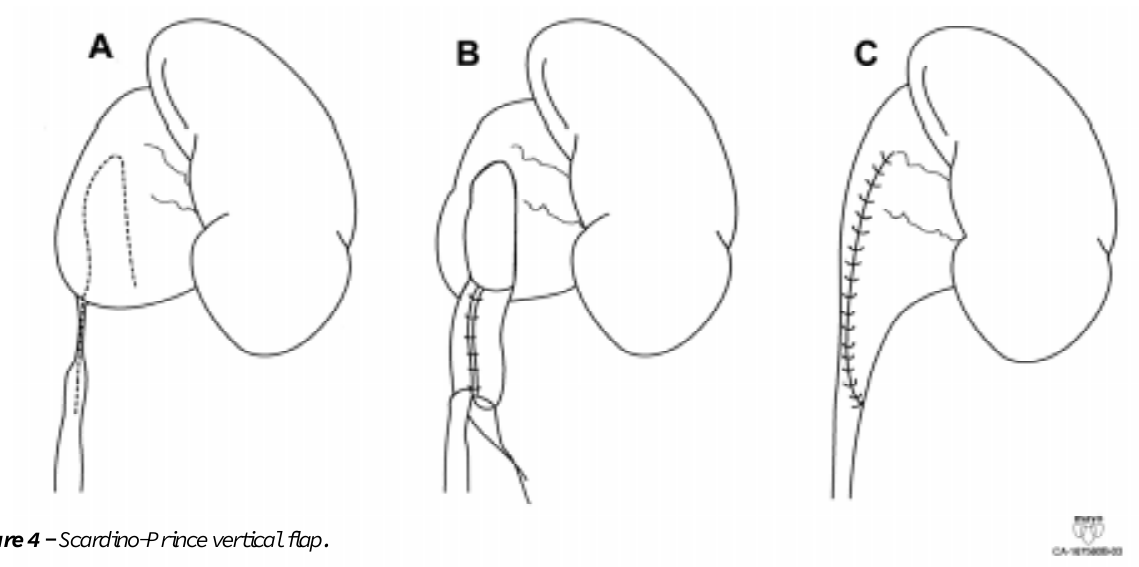
Figure 4 - Scardino-Prince vertical